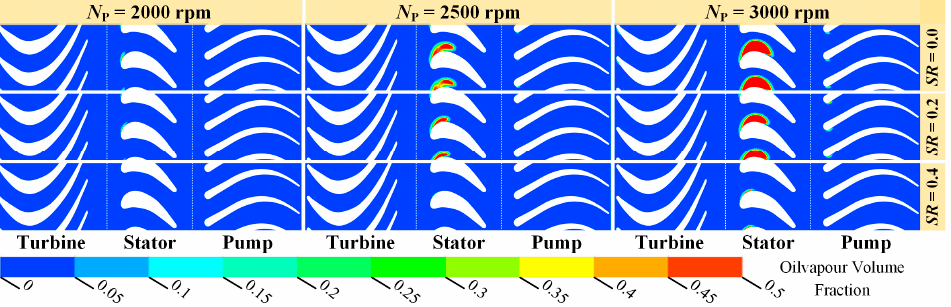
Figure 15. The vapor volume fraction distribution in torque converter under various N P and SR.